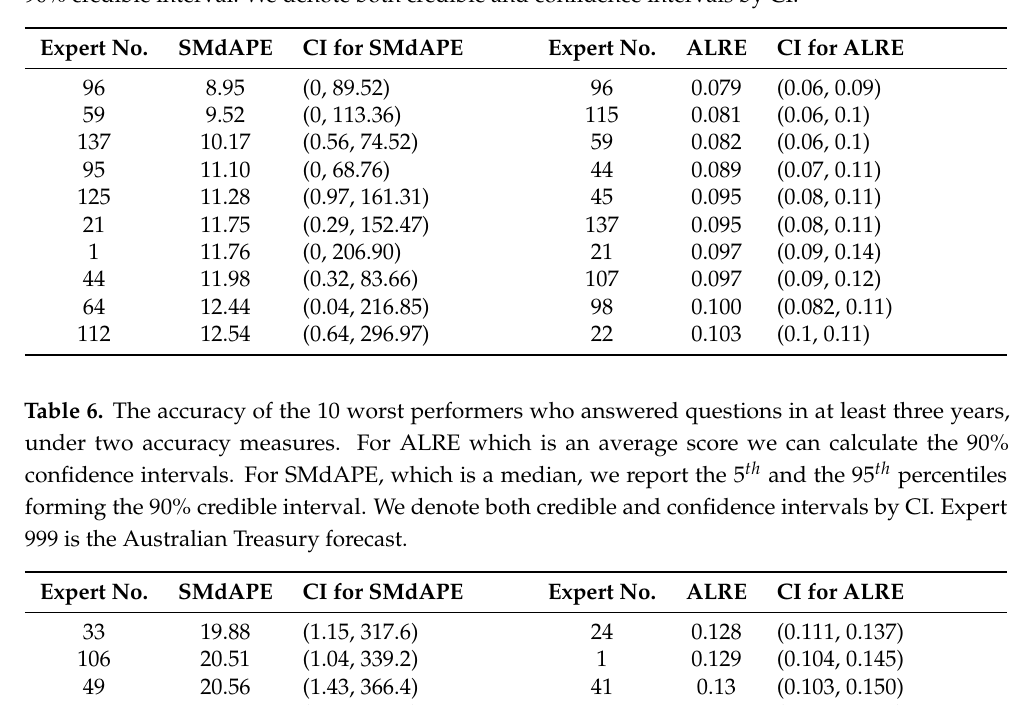
Table 5. The accuracy of the 10 best performers who answered questions in at least three years, under two accuracy measures. For ALRE which is an average score we can calculate the 90% confidence intervals. For SMdAPE, which is a median, we report the 5 th and the 95 th percentiles forming the 90% credible interval. We denote both credible and confidence intervals by CI.